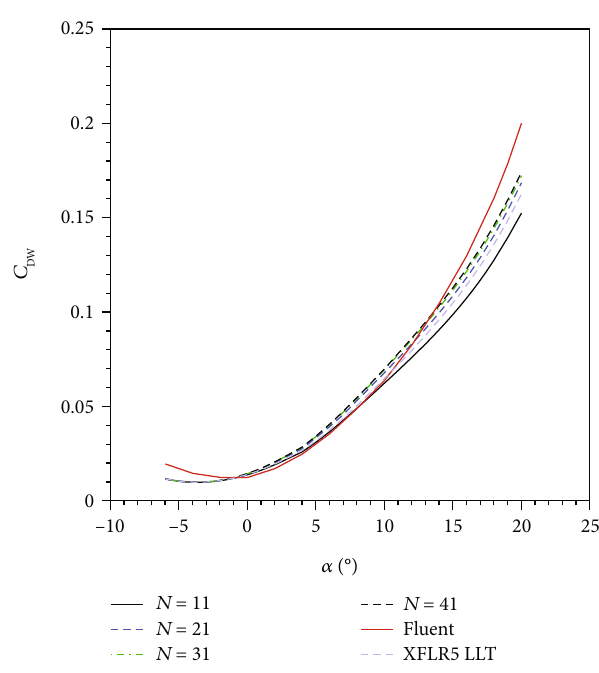
Figure 4: C vs. α curves of the aerodynamic design tool, ANSYS- L Fluent, and XFLR5.